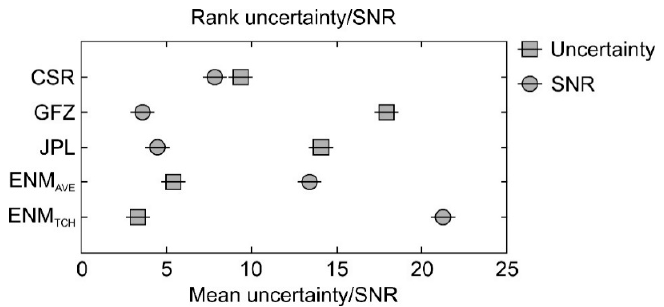
Figure 5. Multiple comparison procedure (MCP) ranking of the various products.